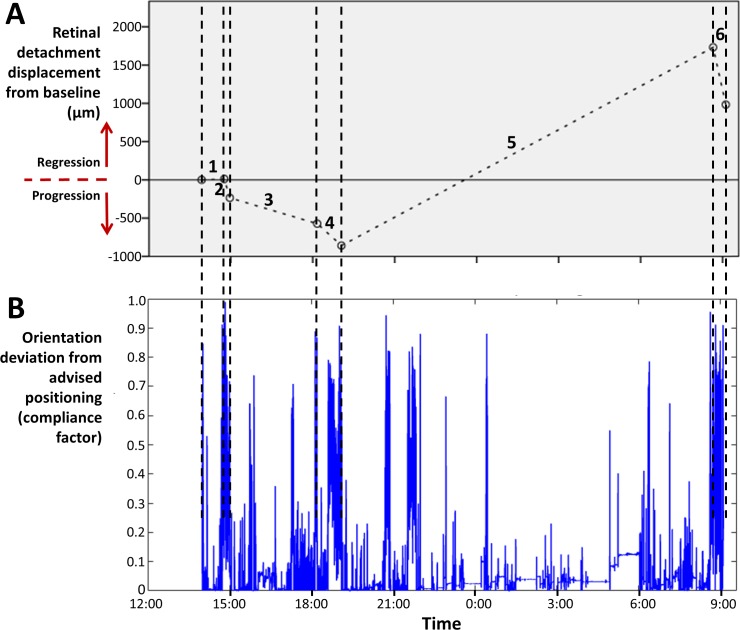
Example of the course of progression and the IMU parameters of a 56-year-old patient. The patient had an RD in the superior temporal quadrant of the right eye and supine posturing. During the day, most intervals showed progression, while during the night, regression of 2591 μm was seen (A). The orientation deviation was lower during posturing intervals than during interruptions, especially during the night (B, interval 5).